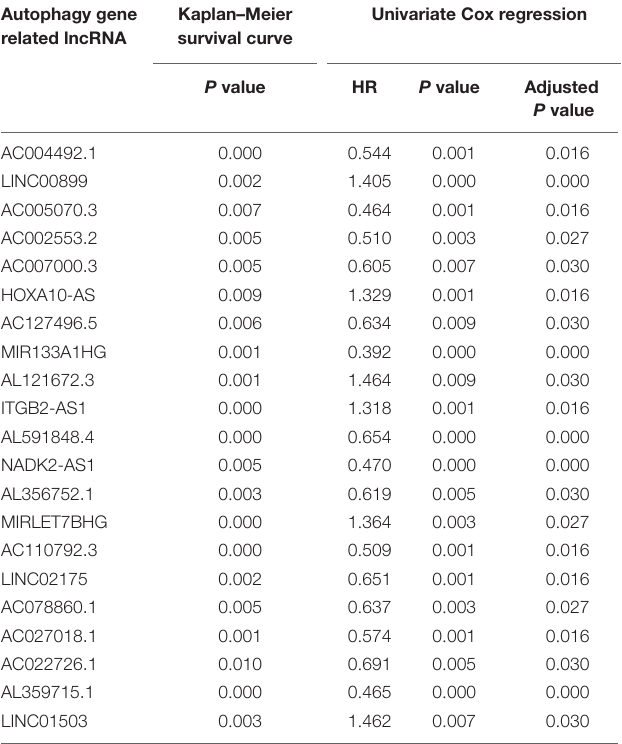
TABLE 1 | Results of 21 lncRNAs from Kaplan–Meier survival curve and Univariate Cox regression in AML patients.